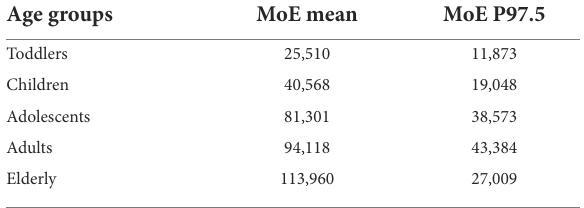
TABLE 8 Margin of exposure (MoE) values, calculated from the median of the mean and 97.5th percentile (P97.5) exposure distributions of the different age groups for the period 2011–2022.